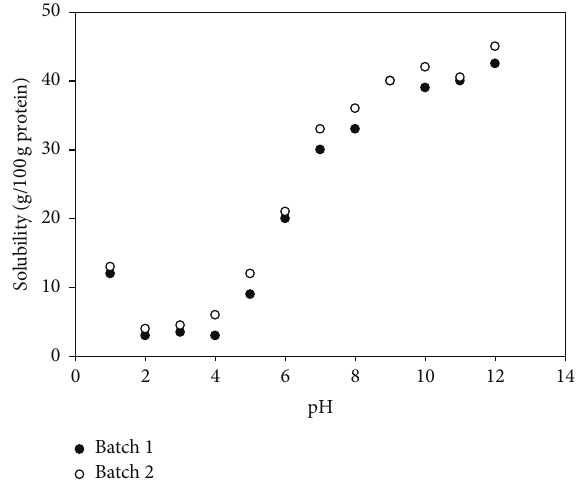
Figure 2: Solubility of the protein concentrates of Grouper skin batches for different